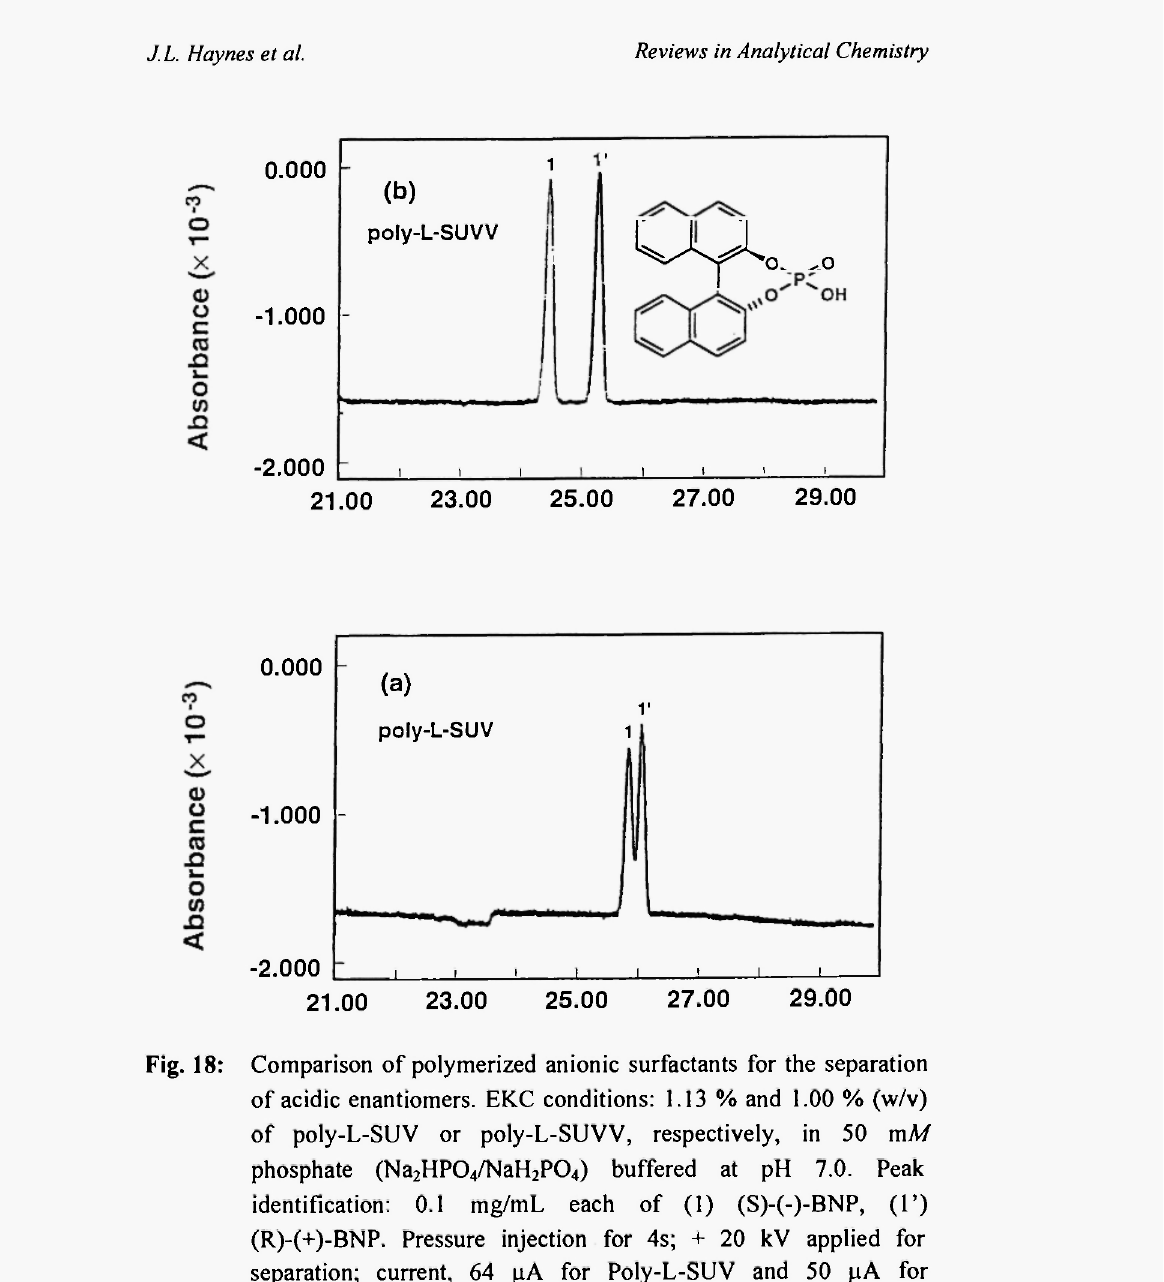
separation; current, 64 μΑ for Poly-L-SUV and 50 μΑ for poly-L-SUVV. UV detection was at 214 nm. From /58/ with